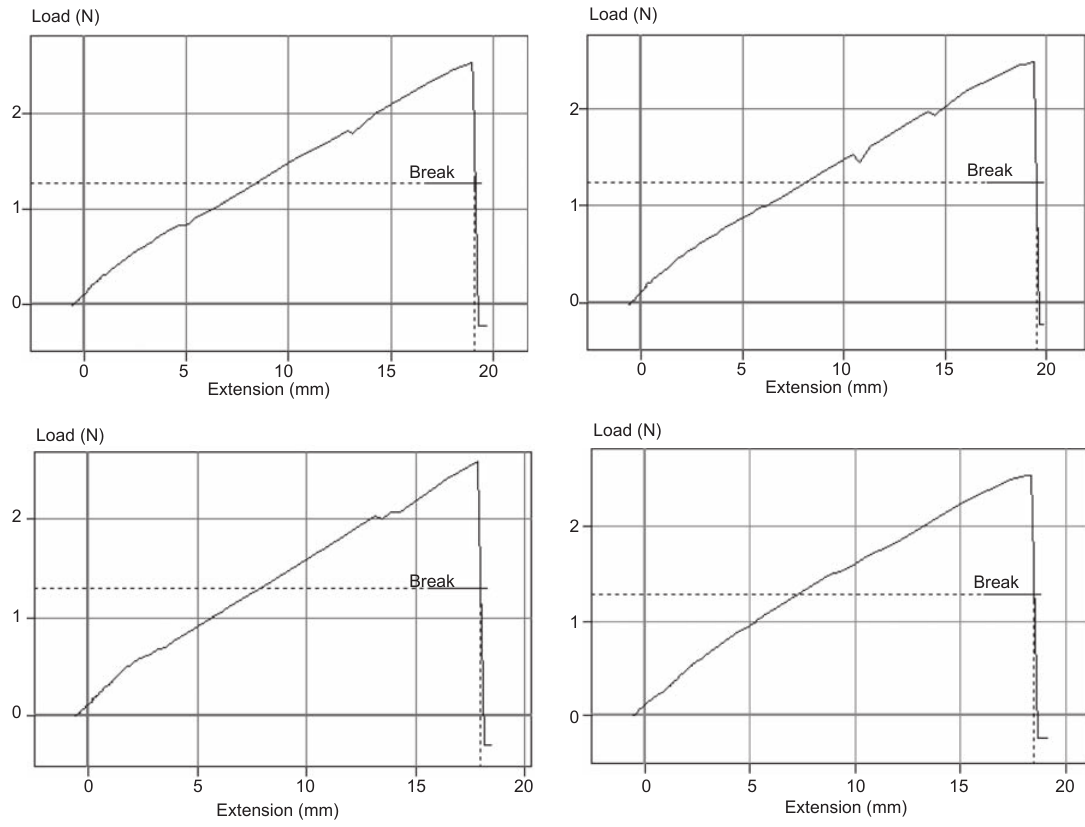
Figure 13 Load-extension curves of the Jetring spun yarns produced with different injector angle and air pressure level.